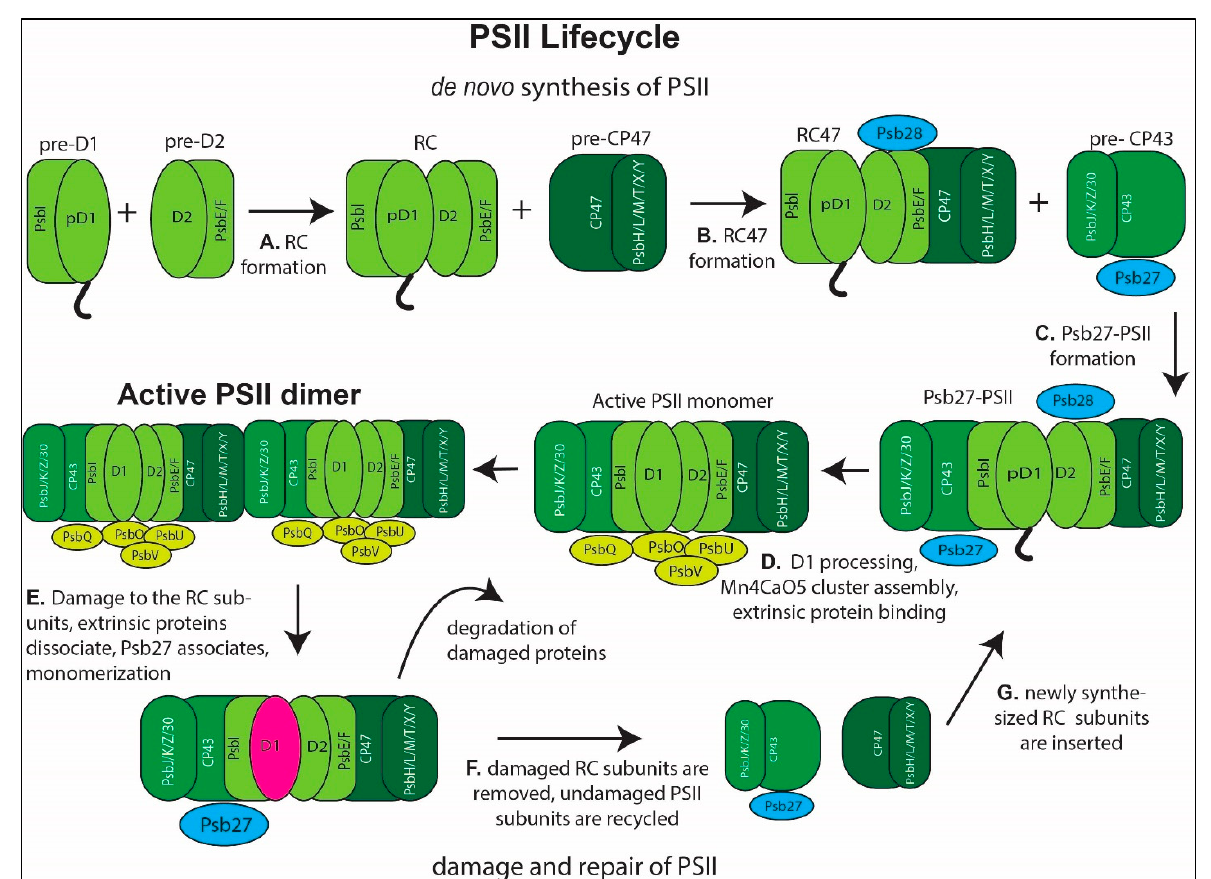
Figure 2. PSII Lifecycle, simplified. Not all accessory assembly chaperones are illustrated . ( A – D ) illustrate de novo synthesis, while ( D – G ) illustrate the repair cycle. ( A ) The pre-D1 and pre-D2 complexes come together to form the RC module. ( B ) RC and pre-CP47 modules come together to form the RC47 complex. Psb28 binds at this stage. ( C ) Psb27-PSII forms from pre-CP43 module and RC47. ( D ) The active PSII monomer is formed in a series of steps, which include processing of the D1 C-terminus, photo-assembly of the Mn 4 CaO 5 cluster, and binding of extrinsic proteins PsbO, PsbV, PsbU, and PsbQ. The active PSII dimer forms following complete monomer assembly. ( E ) Following a photodamage event, the extrinsic proteins dissociate, Psb27 binds, and the dimer dissociates into monomers. ( F ) Damaged subunits are removed and proteolytically degraded. ( G ) Newly synthesized PSII subunits are inserted into recycled subunits to form a Psb27-PSII complex and the repair pathway re-joins the de novo synthesis pathway.